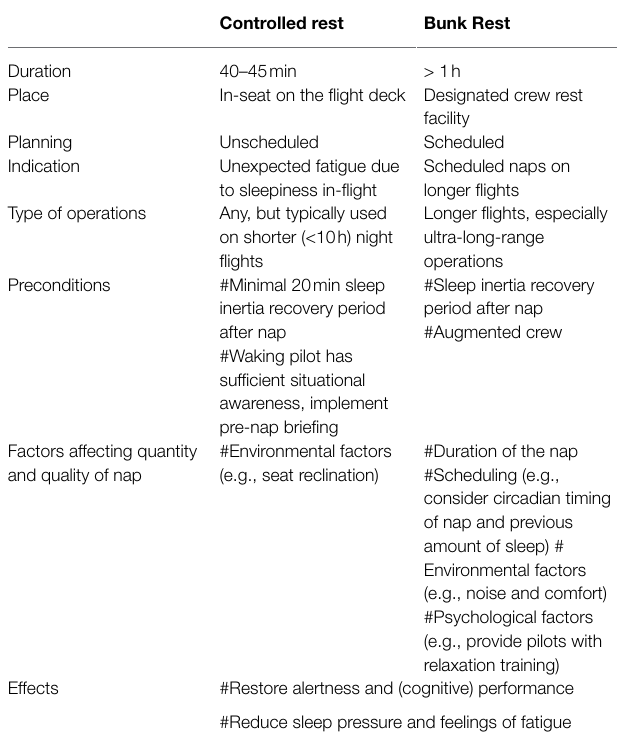
Controlled rest Bunk Rest